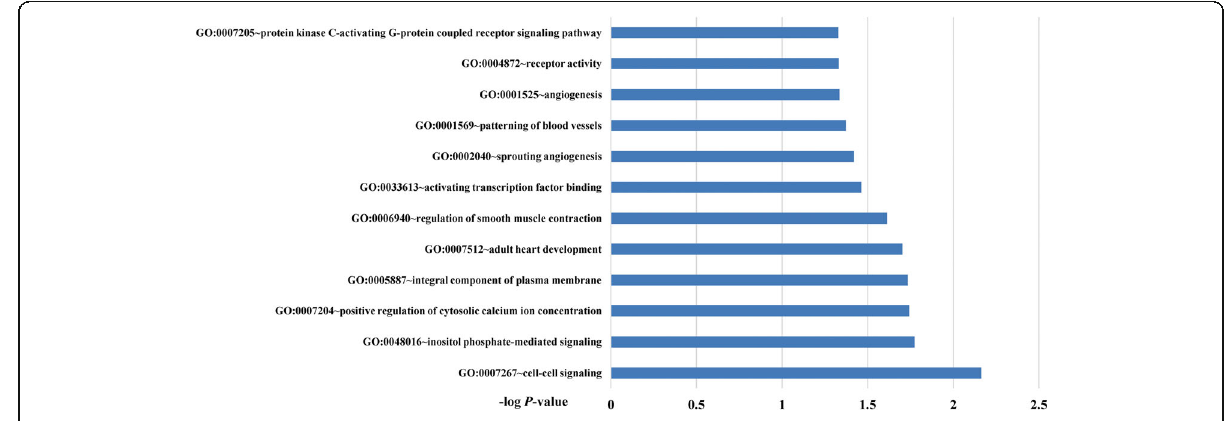
Fig. 2 Gene ontology enrichment analysis of migraine. The cut-off P -value for this analysis was 0.05 ( − log P -value =